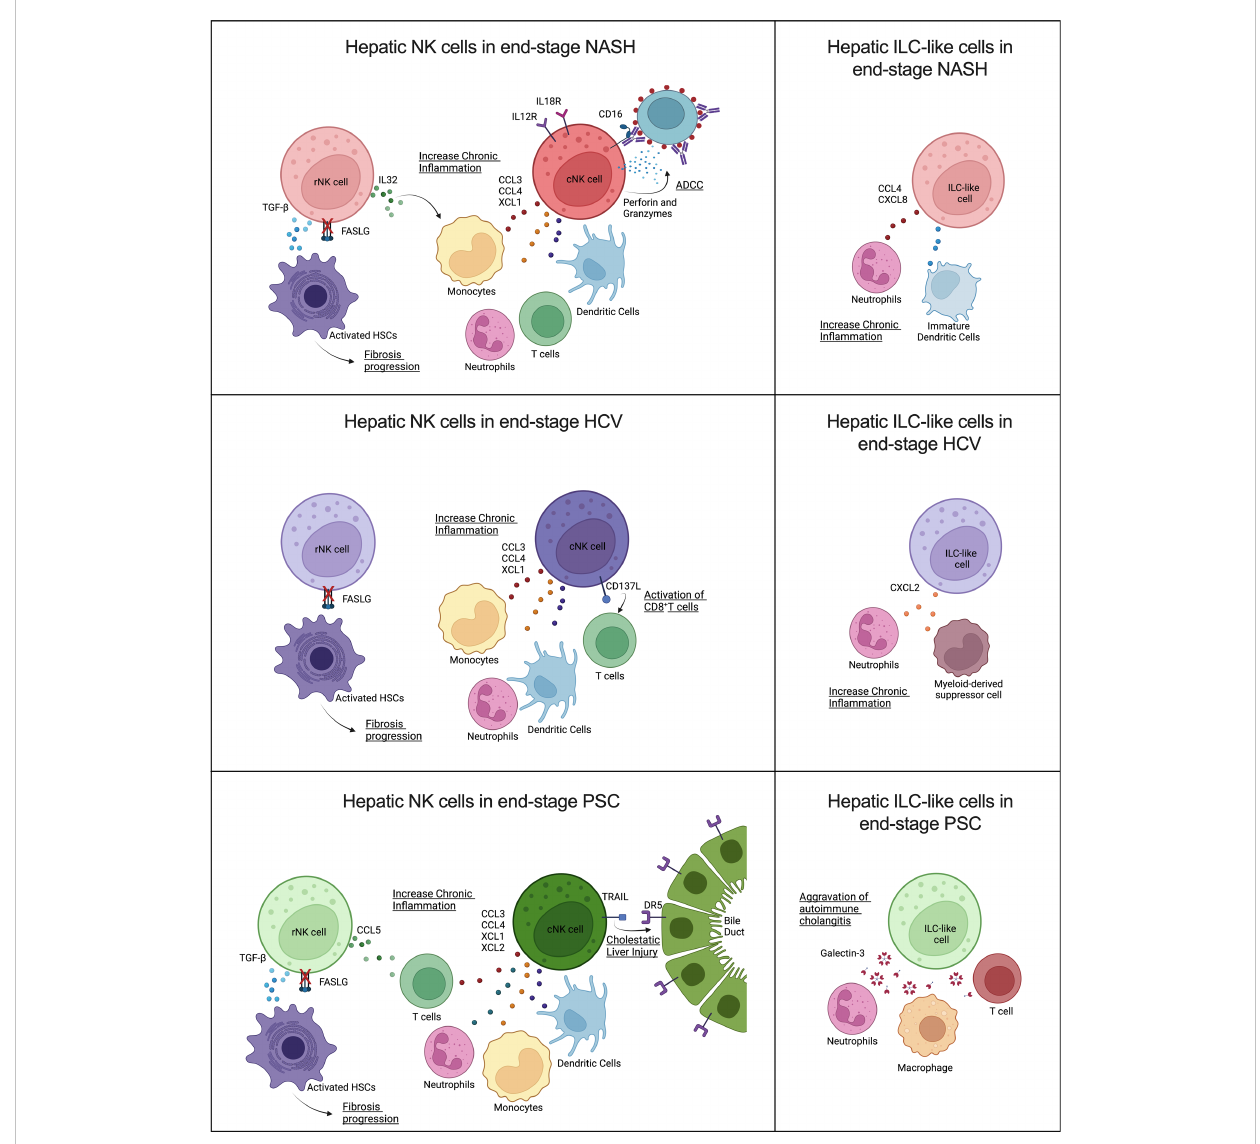
FIGURE 9 Contribution of human hepatic resident and circulating NK cells and ILC-like cells to end-stage liver diseases caused by (A) NASH, (B) HCV, and (C) PSC. Overall, cNK cells and ILC-like cells may contribute in different ways to chronic in fl ammation, while rNK cells may favor hepatic fi brosis progression by failure to kill activated hepatic stellate cells (HSC) due to inhibition of FASLG (Created with